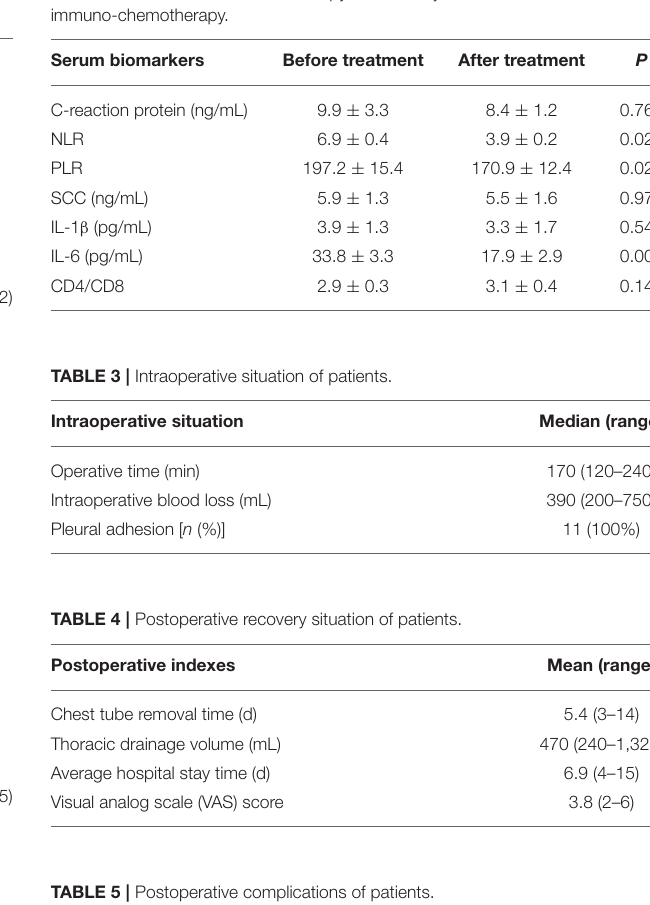
TABLE 1 | Clinical data of patients. TABLE 2 | Comparison of changes in serum laboratory biomarkers of patients